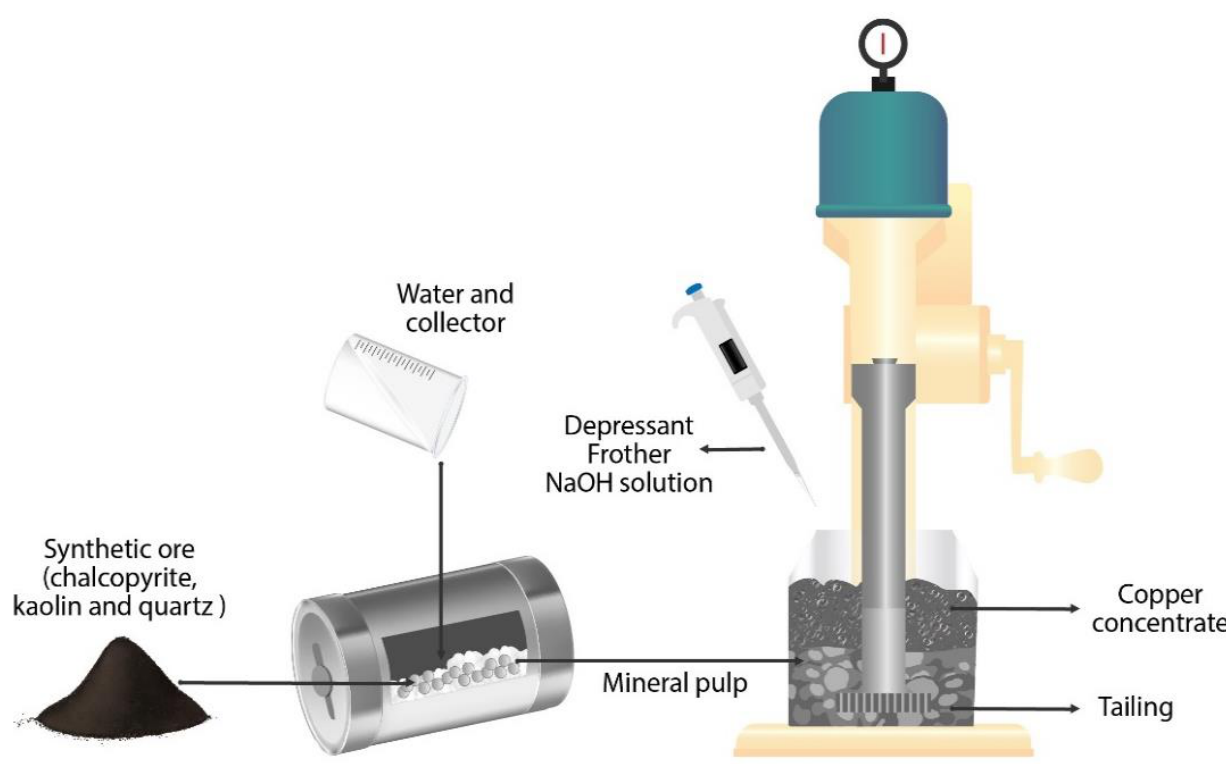
Figure 2. Experimental unit used in the froth flotation tests.